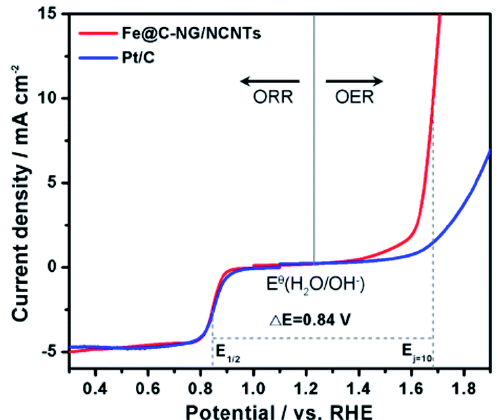
Figure 8. OER/ORR performance of Fe@C–NG/NCNTs and Pt/C is shown in the figure.